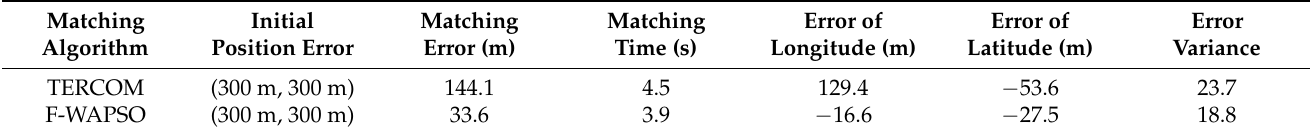
Table 5. Matching and error statistics of the two algorithms for trajectory C.